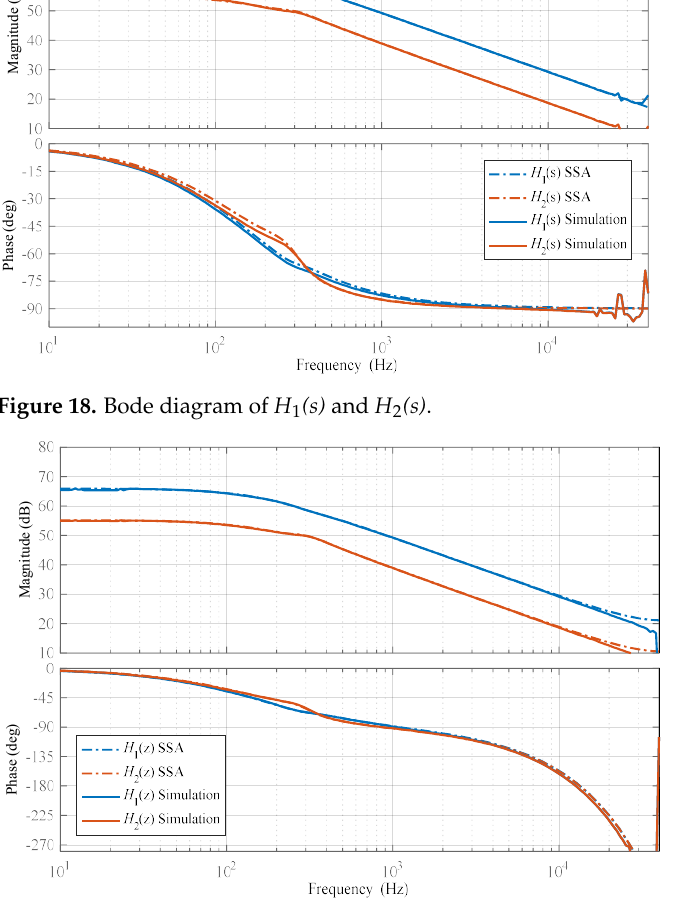
Figure 19. Bode diagram of H 1 (z) and H 2 (z) .